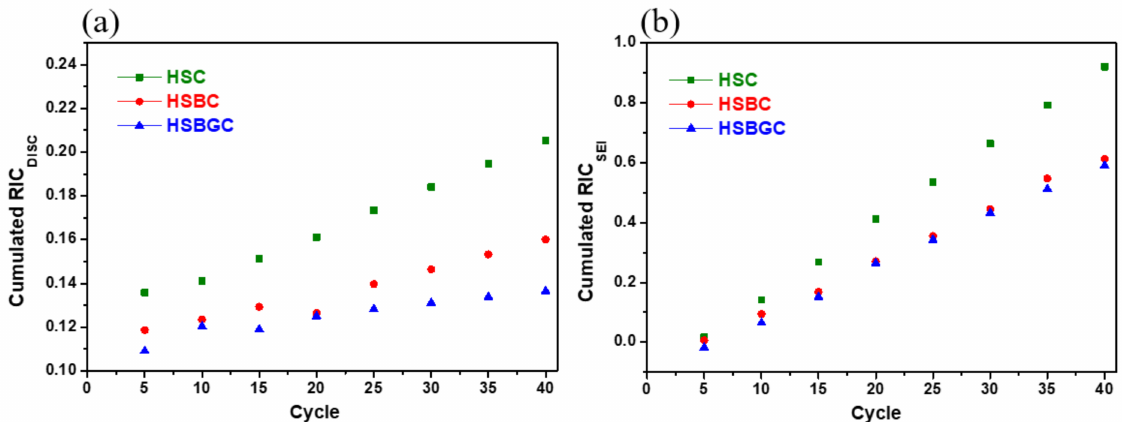
Figure 8. Cumulated relative irreversible capacities related to ( a ) electrical disconnection and ( b ) SEI for HSC, HSBC and HSBGC electrodes.